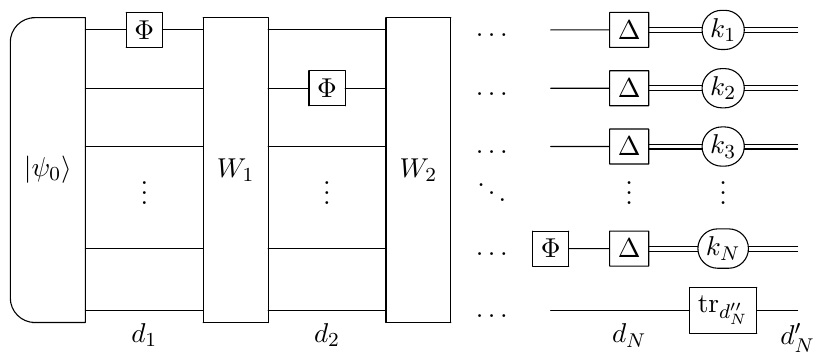
Figure 3. Application of an adaptive scenario �( P P 1 , P U } . ∈ {